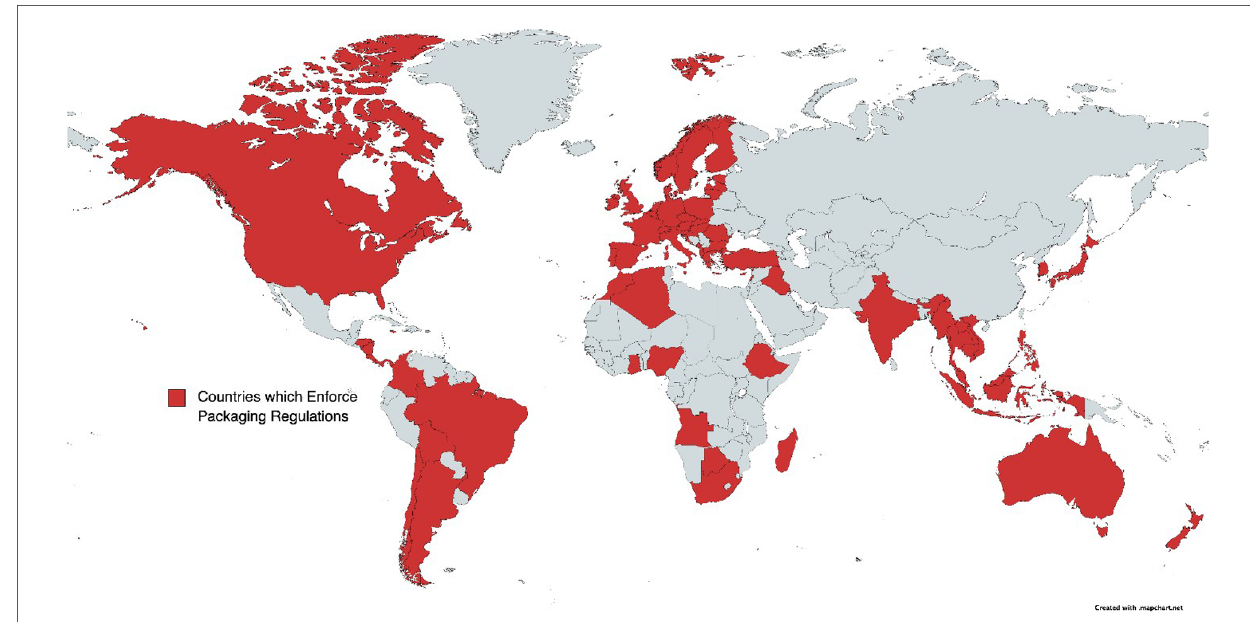
FIGURE 1 Countries which enforce allergen labeling regulations for packaged